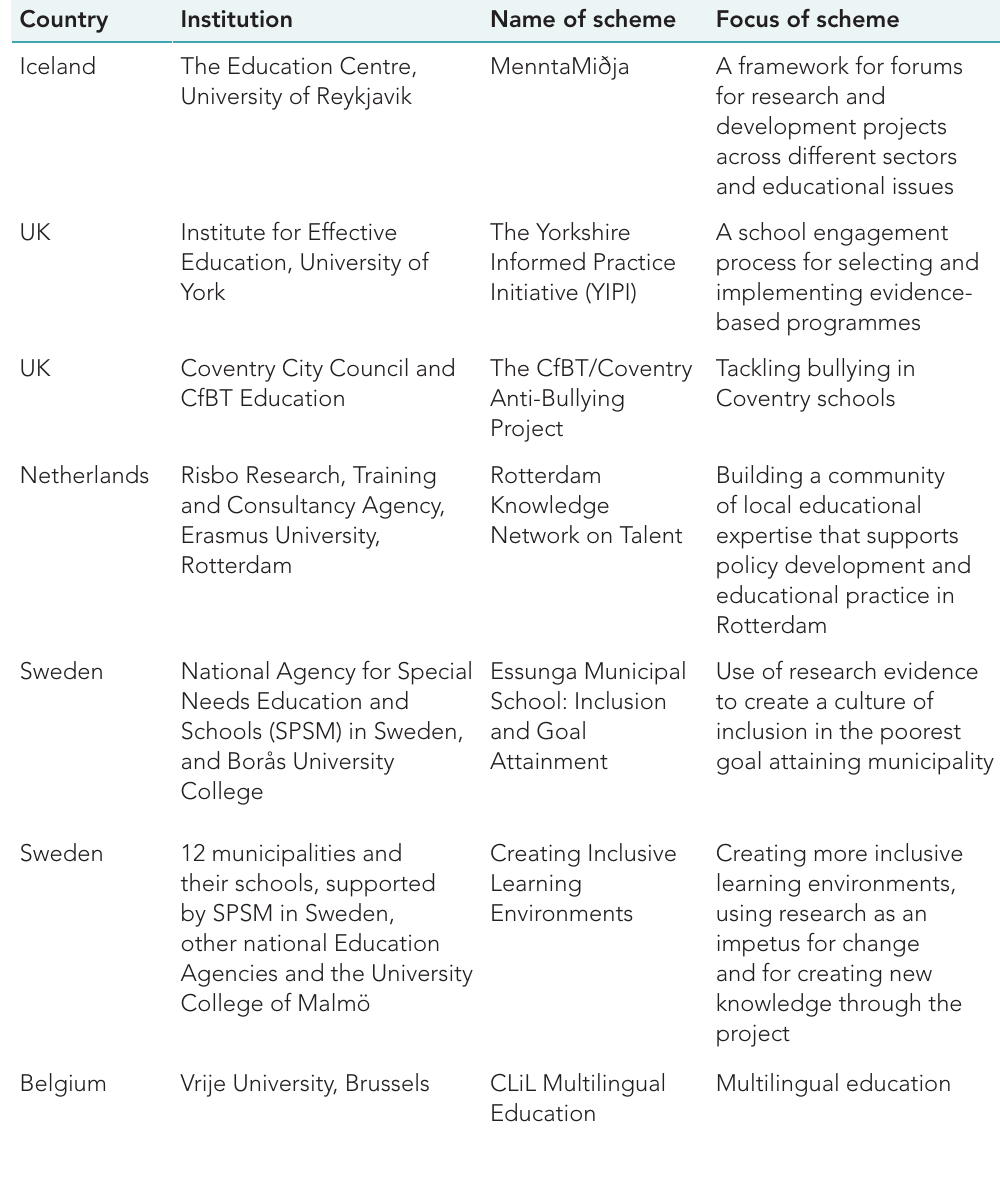
Table 1: The 13 schemes participating in the 2013 survey